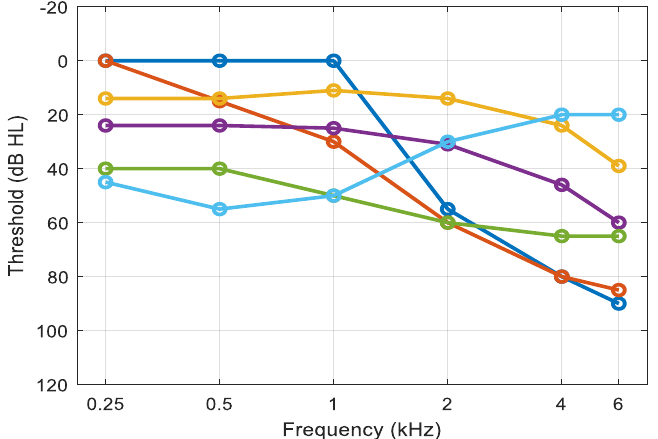
Figure 2. Typical hearing loss audiograms incorporated in the objective evaluation of sound quality and intelligibility using HASPI and HASQI measures. These include two high-frequency hearing loss audiograms (HL1: blue, HL2: orange), two mild hearing loss audiograms (HL3: yellow, HL4: purple), one moderate hearing loss (HL5: green), and one low-frequency hearing loss (HL6: cyan).